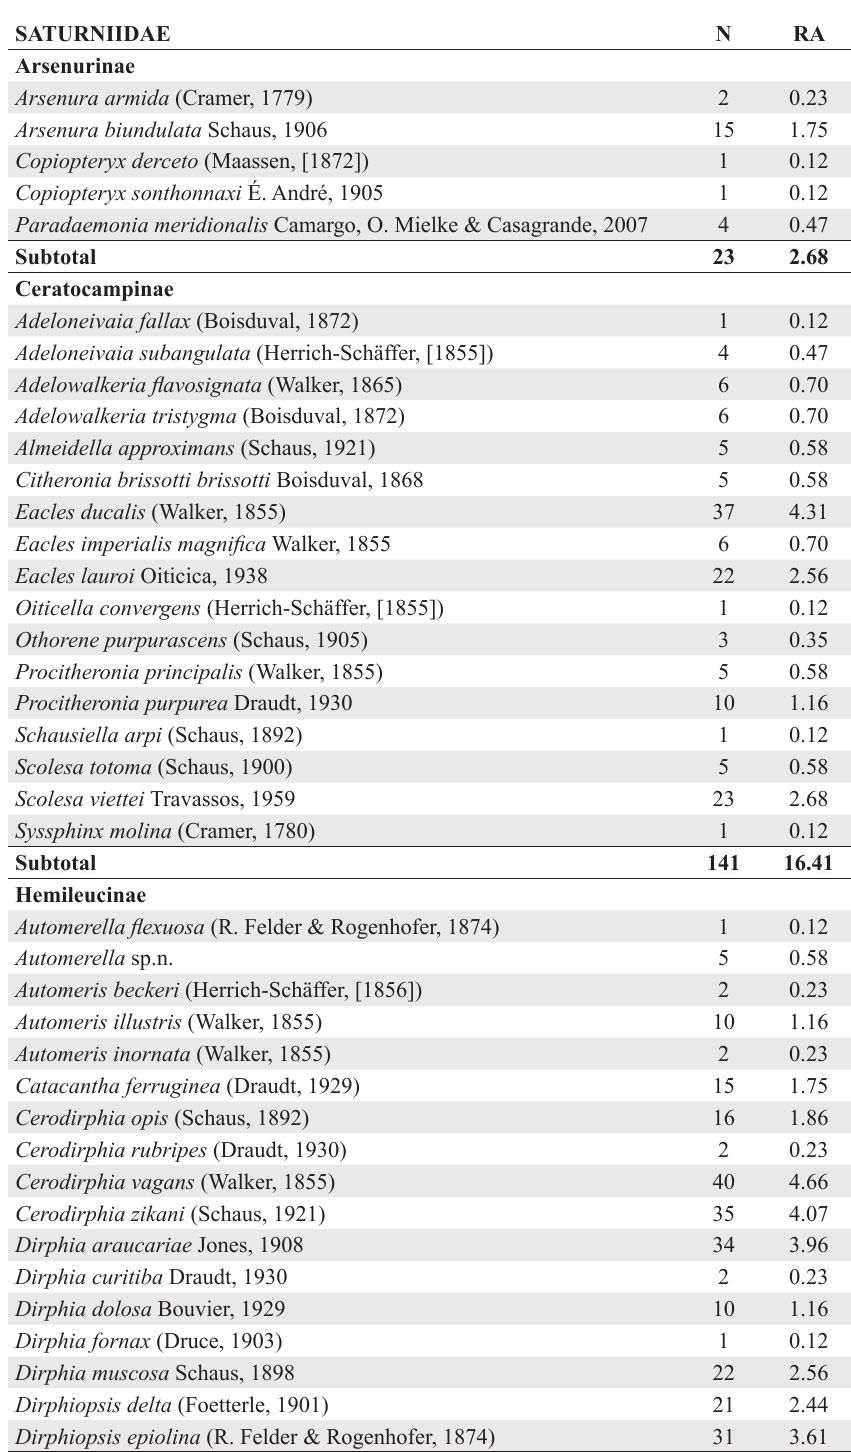
Checklist of the species of Saturniidae and Sphingidae with their abundance (N) and relative abundance